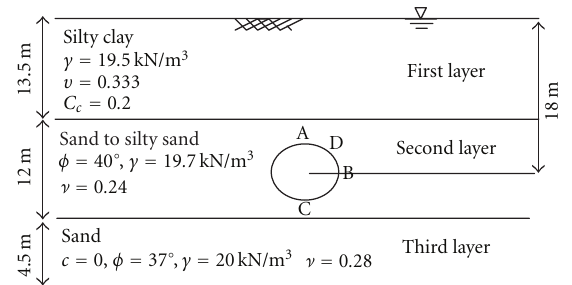
Figure 2: Geological profile and soil material properties along Baghdad metro